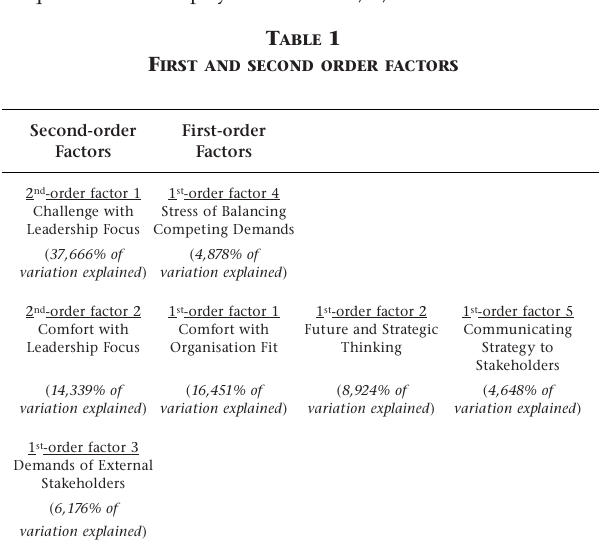
Table 1. The relationships between the factors, the three primary hypotheses used to construct the LFQ, and the LFQ questions are displayed in Tables 2, 3, and